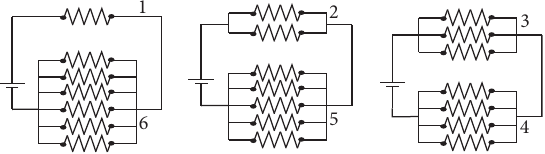
Figure 2: Switch combination equivalent circuit. Table 1: Voltage vector amplitude relation table.